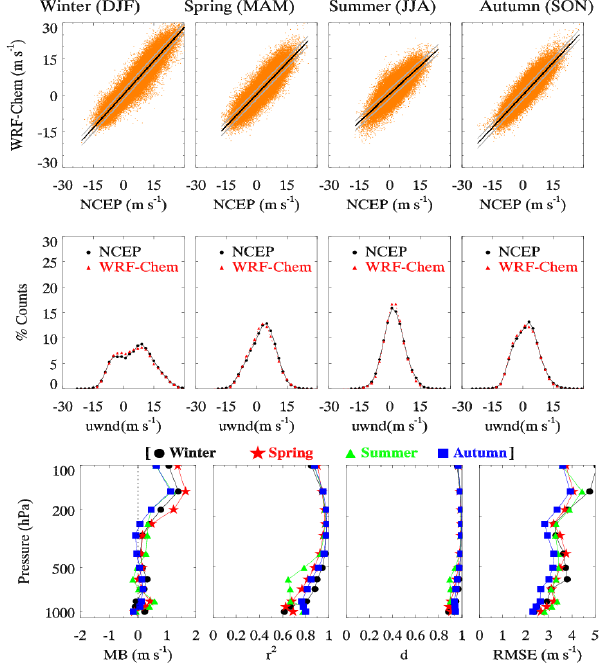
Figure 8: The scatter plots (top panel) and the frequency analyses (middle panel) of NCEP and model zonal wind component at 2 m s -1 interval for 700 hPa during the four seasons of the year 2008. The black lines in the scatter plots represent the linear fit to the data while the grey lines are the 95% confidence interval estimates in the fitted values. The vertical profiles (bottom panel) of MB, r 2 , d and RMSE for each season are also shown.